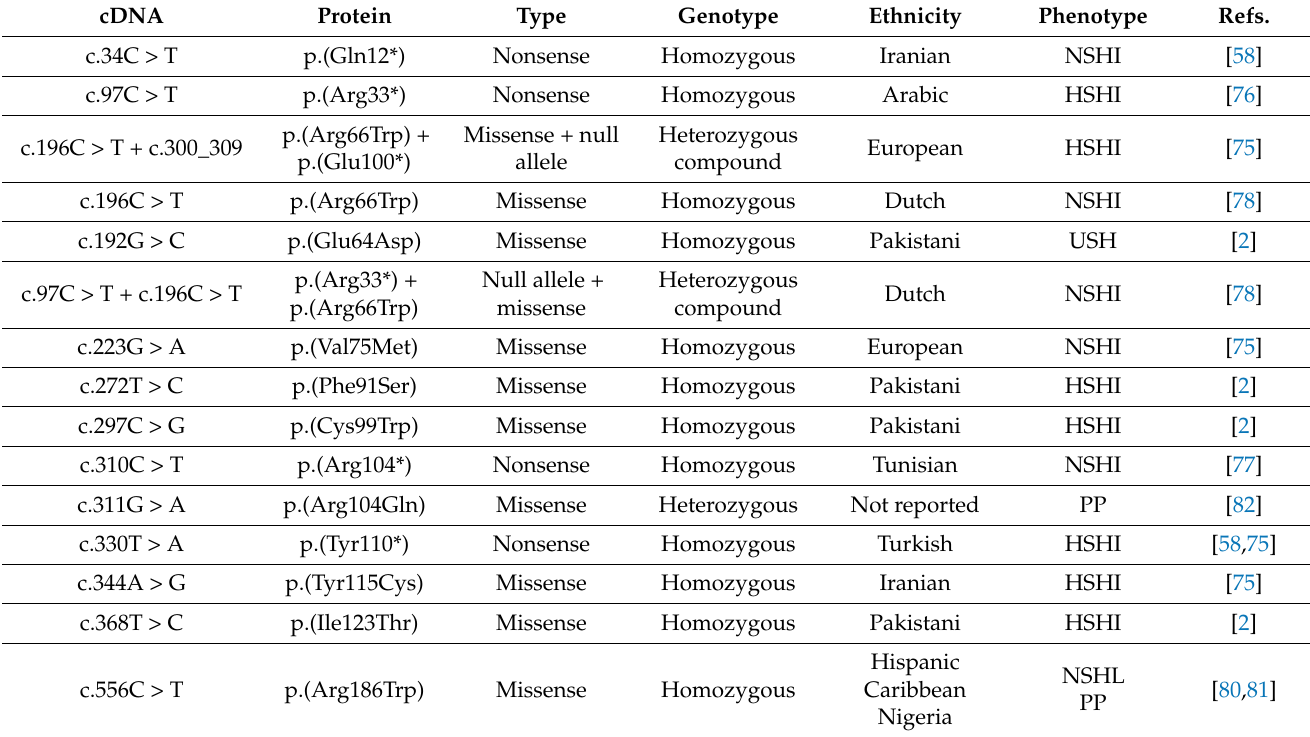
Table 2. Summary of the known mutations in the CIB2 encoding